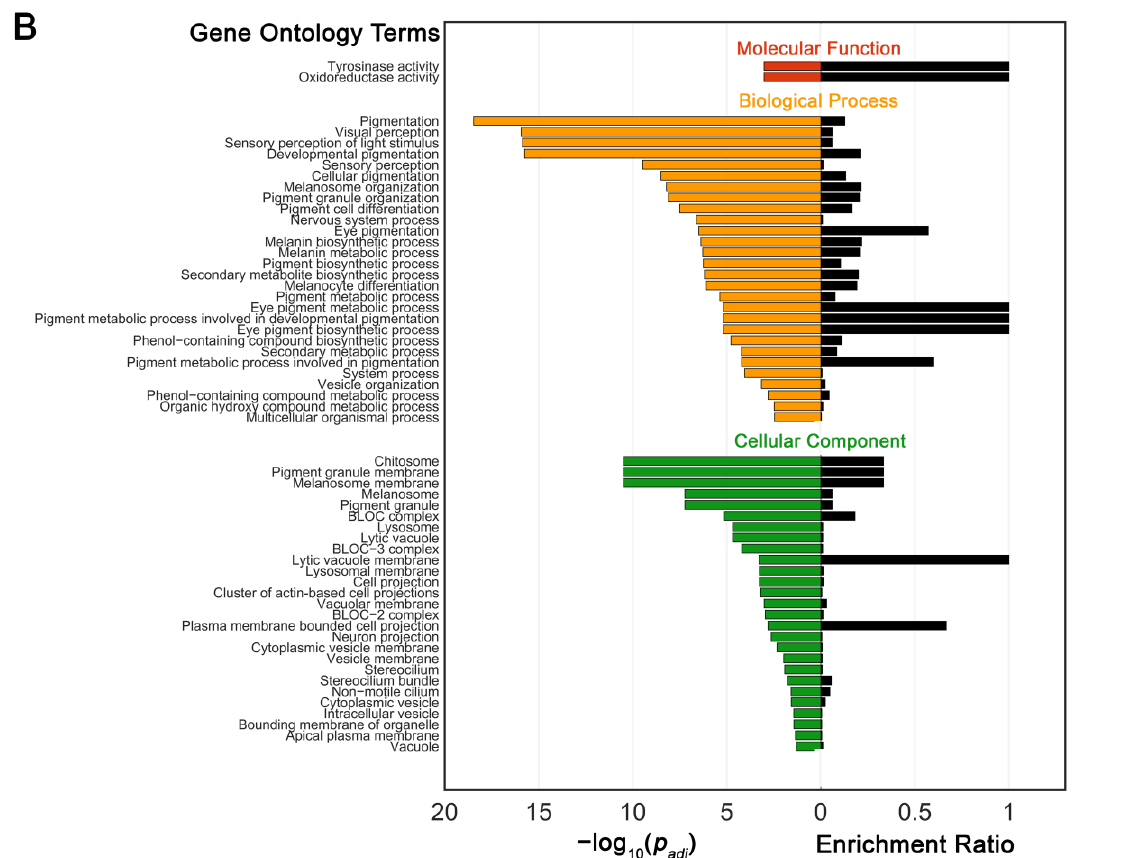
Figure 2. Pathway enrichment analysis depicting significantly enriched gene ontology (GO) terms belonging to ( A ) categories: biological process, molecular function, and cellular component, with corresponding false-discovery rate (FDR) corrected significance values. Term size corresponds to total number of genes associated with a given GO term. ( B ) Detailed list of GO terms with their corresponding enrichment ratio expressed as the number of overlapping genes divided by total term size.